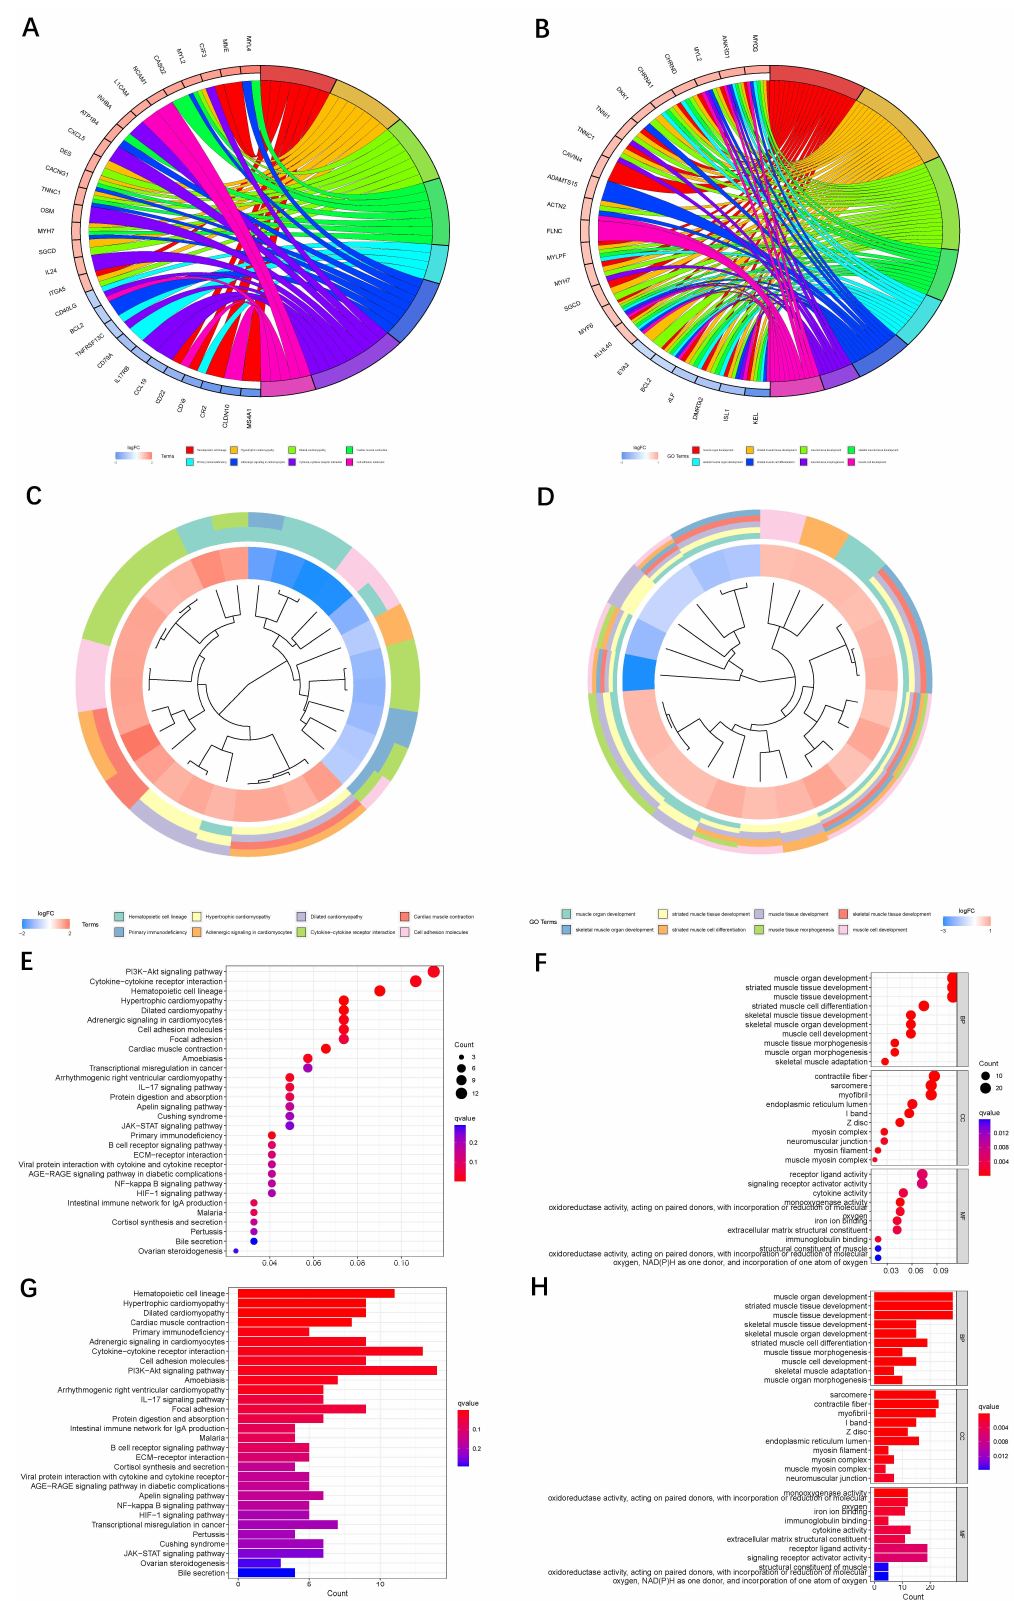
Figure 5. The KEEG and GO analyses of differential genes between the low- and high-risk groups. ( A , C , E , G ): KEGG analysis of the differentially expressed genes in two groups. ( B , D , F , H ): GO analysis of the differentially expressed genes in two